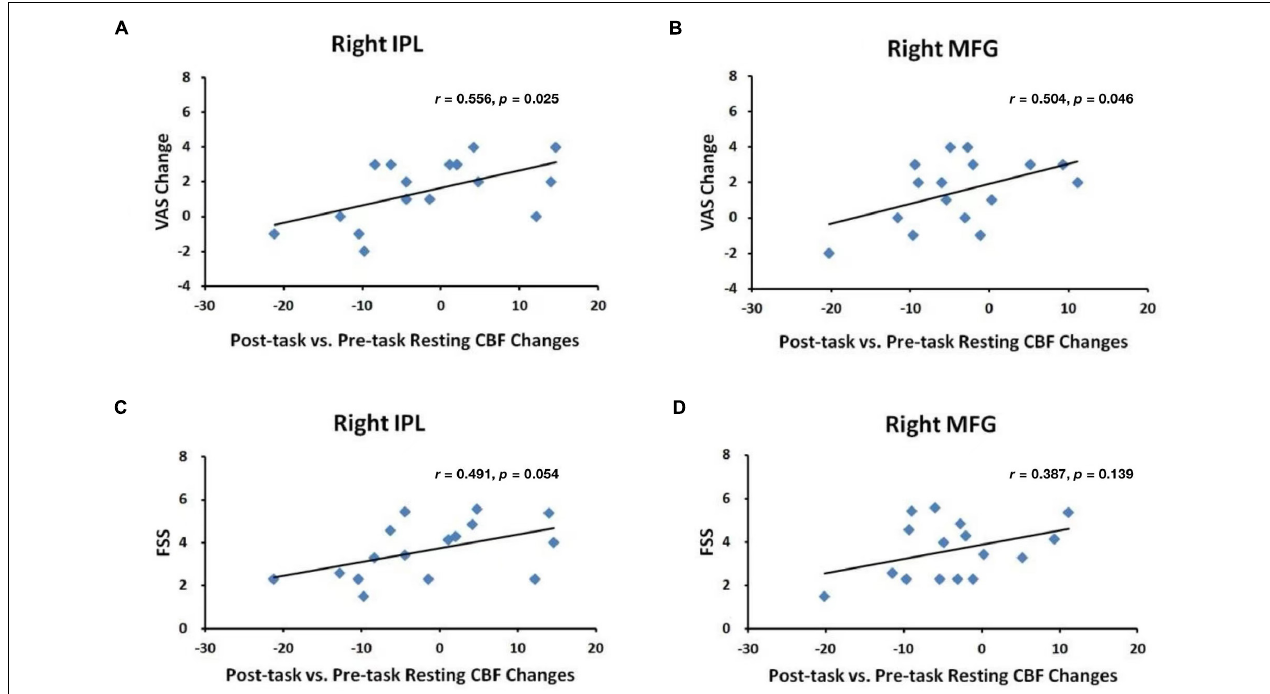
FIGURE 5 | Correlations between VAS changes and post-task regional CBF changes in the (A) right IPL and (B) right MFG and between FSS scores and post-task regional CBF changes in the (C) right IPL and (D) right